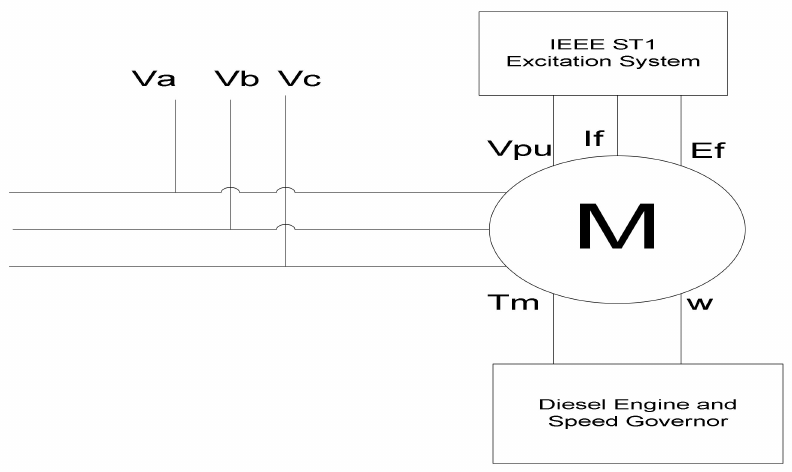
Figure 2. Diesel Generator, exciter and speed